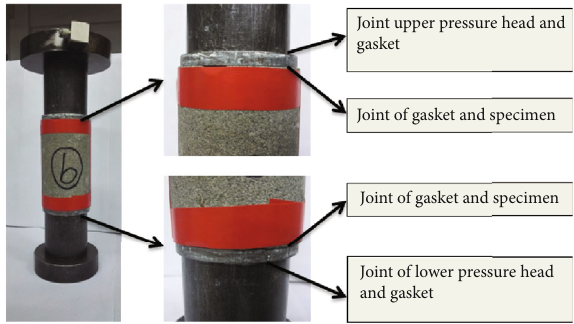
Figure 10: Gap between the sample and permeable gasket and upper and lower pressure heads.